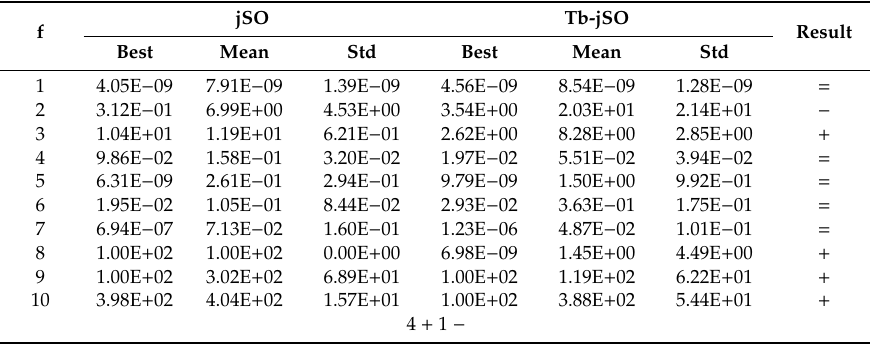
Table 16. jSO vs. Tb-jSO on CEC2020 in 10 D